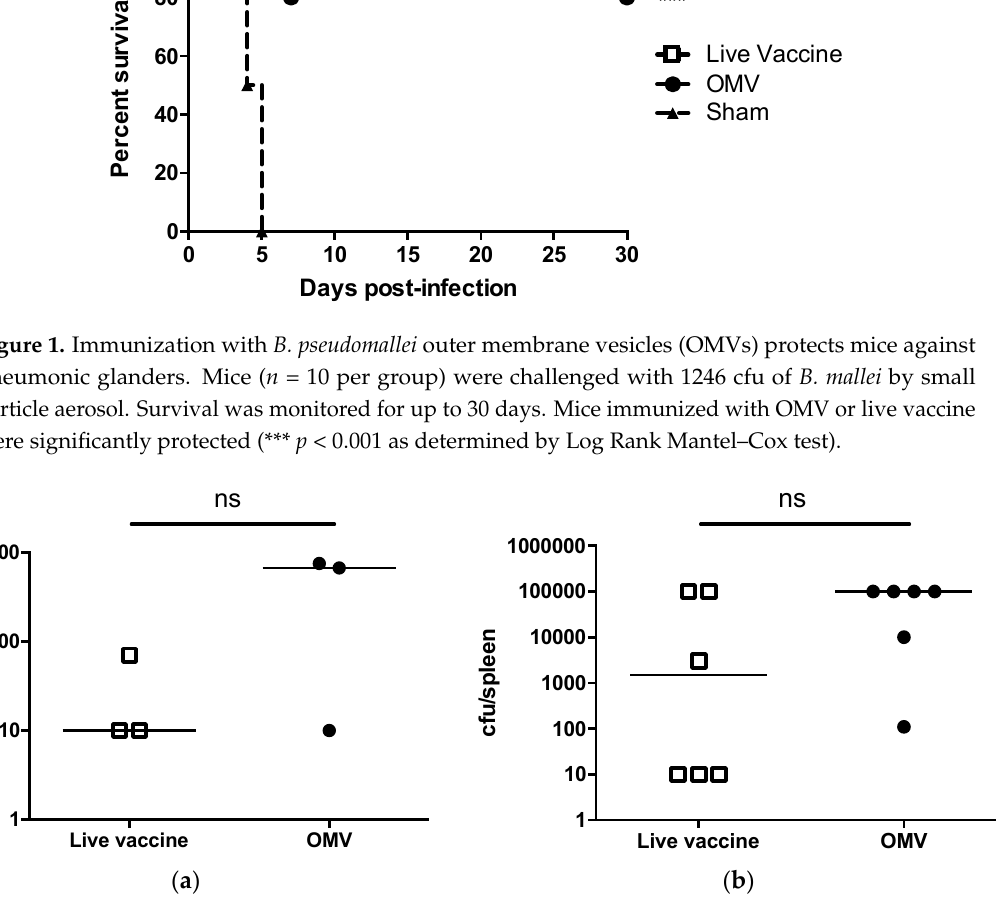
Figure 1. Immunization with B. pseudomallei outer membrane vesicles (OMVs) protects mice against pneumonic glanders. Mice ( n = 10 per group) were challenged with 1246 cfu of B. mallei by small particle aerosol. Survival was monitored for up to 30 days. Mice immunized with OMV or live vaccine were significantly protected (*** p < 0.001 as determined by Log Rank Mantel–Cox test ).